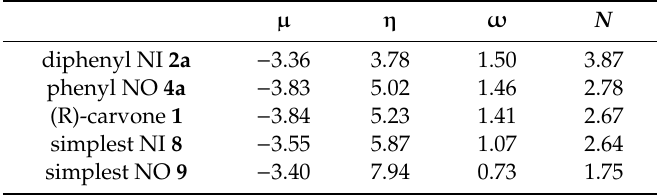
Table 1. B3LYP / 6-31G(d) global electronic chemical potential, µ , chemical hardness, η , electrophilicity, ω , and nucleophilicity, N , in eV, of NIs 2a , 8 , NOs 4a, 9 and (R)-carvone 1 . µ η ω N diphenyl NI 2a − 3.36 3.78 phenyl NO 4a −